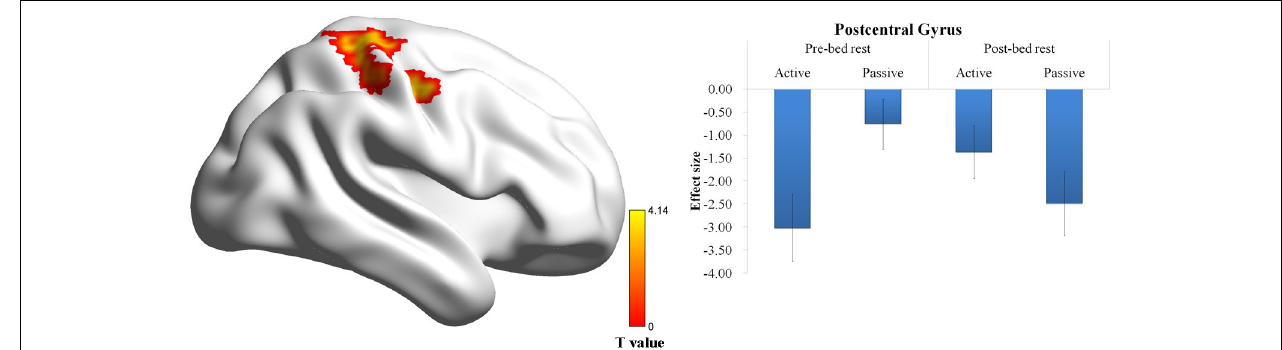
FIGURE 3 | Outcome-related brain regions showing the Two-Way interaction between time and choice condition. The activation of post-central gyrus in the active choice condition was greater after the